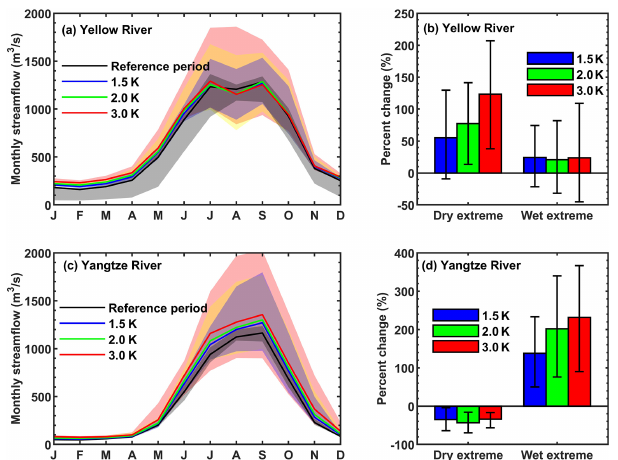
Figure 5. Changes of streamflow and its extremes at the outlets of the headwater regions of the Yellow River and the Yangtze River, i.e., Tangnaihai gauge and Zhimenda gauge. (a) Simulated monthly streamflow over the Yellow River during the reference pe- riod (1985–2014) and the periods with different global warming levels. Solid lines represent ensemble means, while shadings are ranges of individual ensemble members. (b) Percent changes in the frequency of dry and wet extremes in July–September at differ- ent warming levels. Colored bars are ensemble means, while error bars are 5%–95% uncertainty ranges estimated using bootstrapping 10000 times. Panels (c) and (d) are the same as (a) and (b) but for the Yangtze